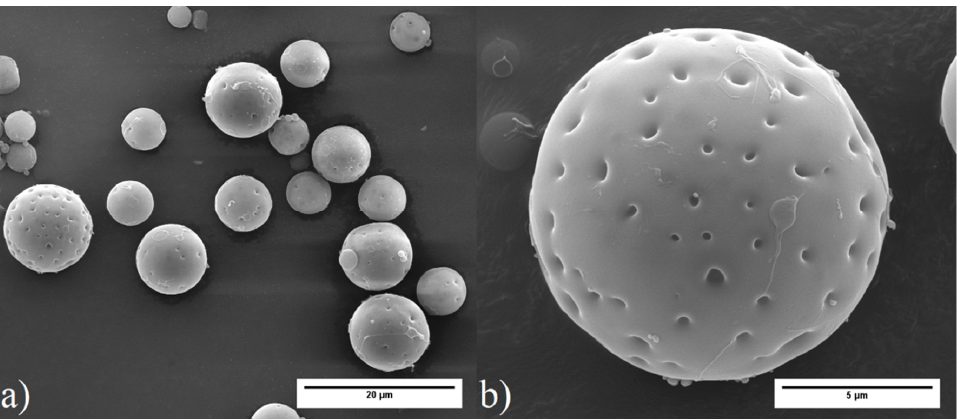
Figure 1. SEM images of MHP (magnification: ( a ) 4000x; ( b ) 16000x).